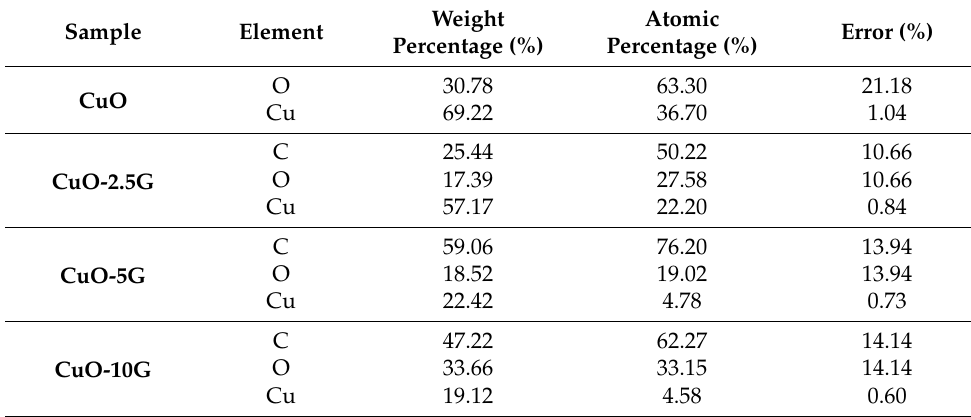
Figure 3. FESEM images of the samples: ( a ) CuO-5G and ( b ) CuO-10G. Table 5. Weight percentage and atomic percentage of the elements present in the